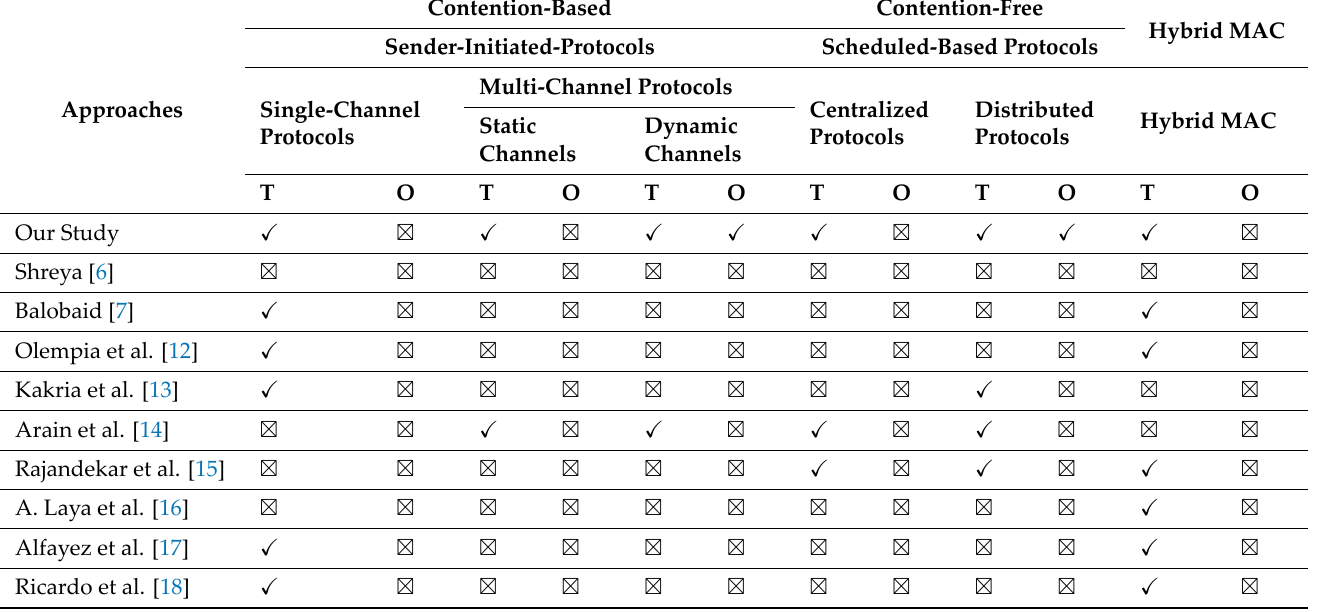
Table 2. Summary and comparison of our study and recent